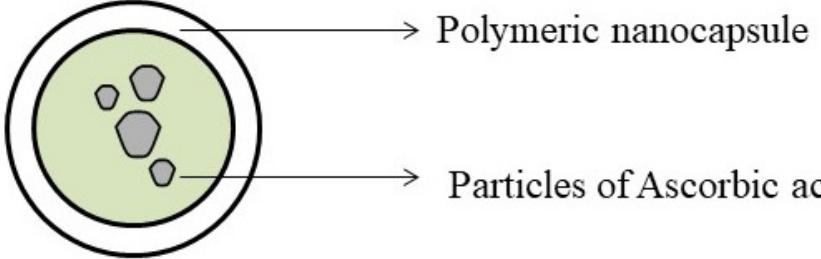
Figure 13. Nanoparticles containing drug particles. Zhou et al., in 2017 developed nanoparticles with a dual drug delivery approach for synergistic cancer treatment by encapsulating ascorbyl palmitate (AP) and paclitaxel (PTX) and evaluating their anticancer potential against the B16F10 cell line. Dynamic